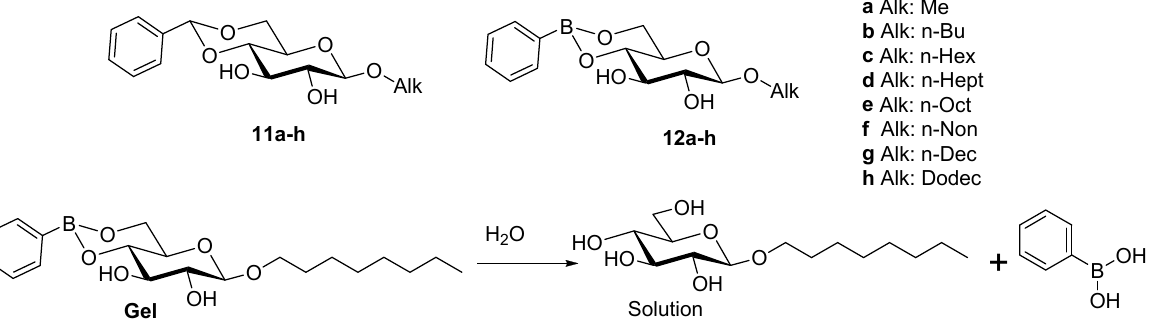
Figure 5. Structures of phenyl boronic ester protected alkyl glucoside derivatives [44].